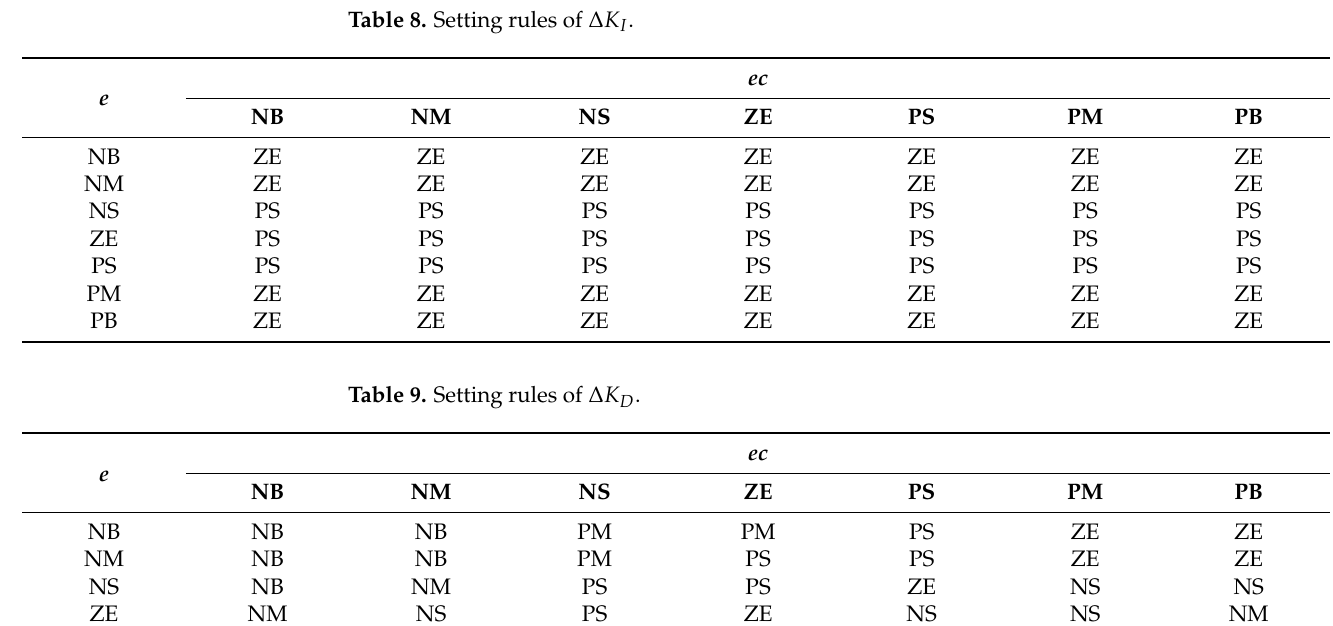
Table 8. Setting rules of ∆ K I .